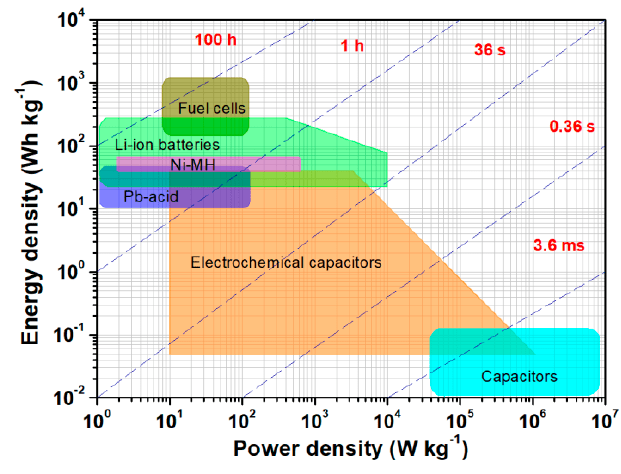
Figure 1. Ragone chart [30].